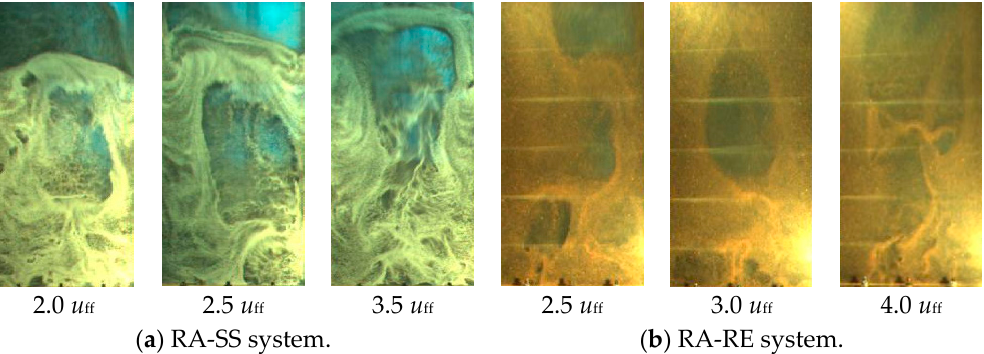
= 0.3). Energies 2018 , 11 , x FOR PEER REVIEW b